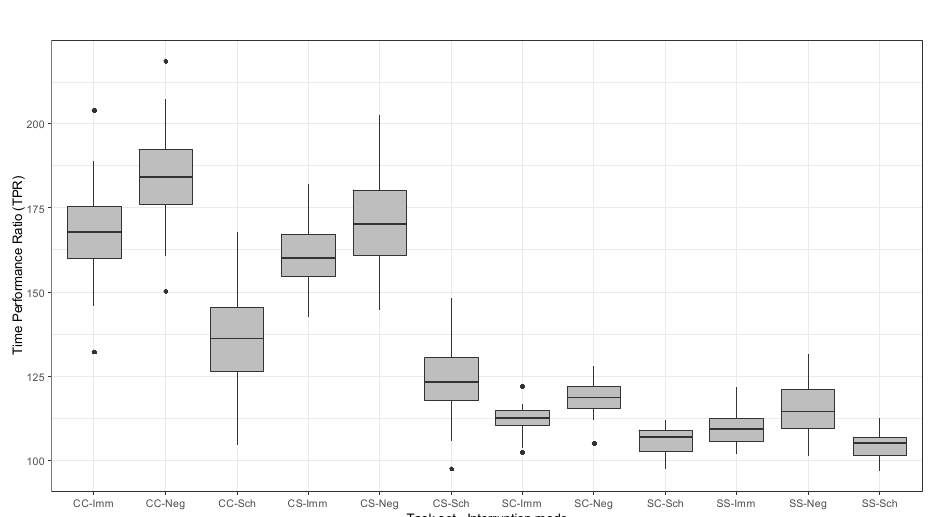
Figure 6. Task completion time by task set and interruption coordination mode.